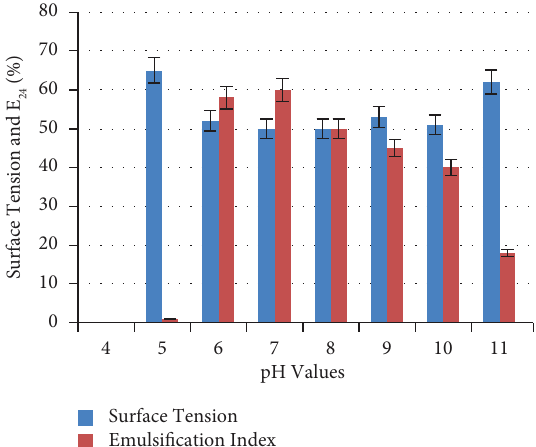
Figure 5: Efect of diferent incubation temperatures on bio- surfactant production. 30 ° C was the optimum temperature with the highest E 24 % (60 ± 0.33%) and lowest surface tension at 50 ± 0.33mN/m.